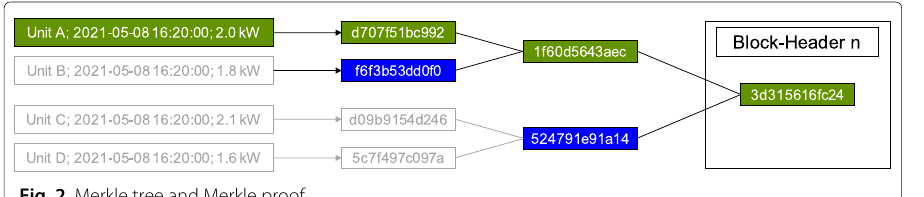
Fig. 2 Merkle tree and Merkle